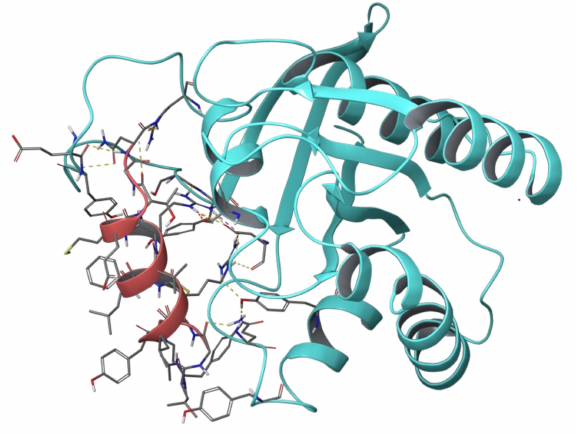
Figure 8. Frame of the MD simulation performed on the combinatorial peptide forty-three in complex with the Ras protein, depicting the binding mode of the